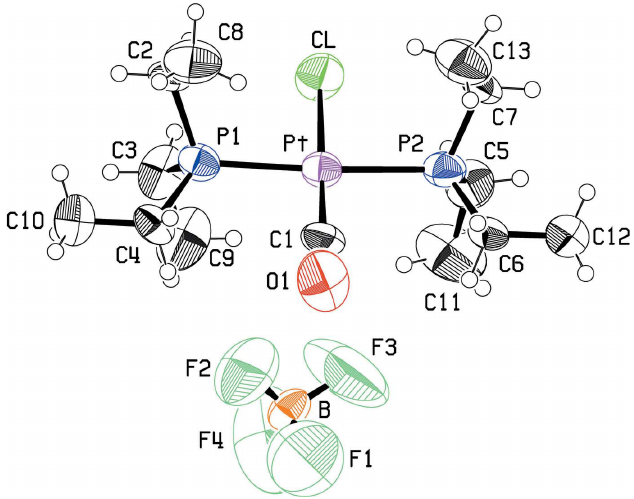
Figure 3 Hirshfeld d norm surface for the BF 4 (cid:2) anion, showing the red area that indicates close contacts for F2.